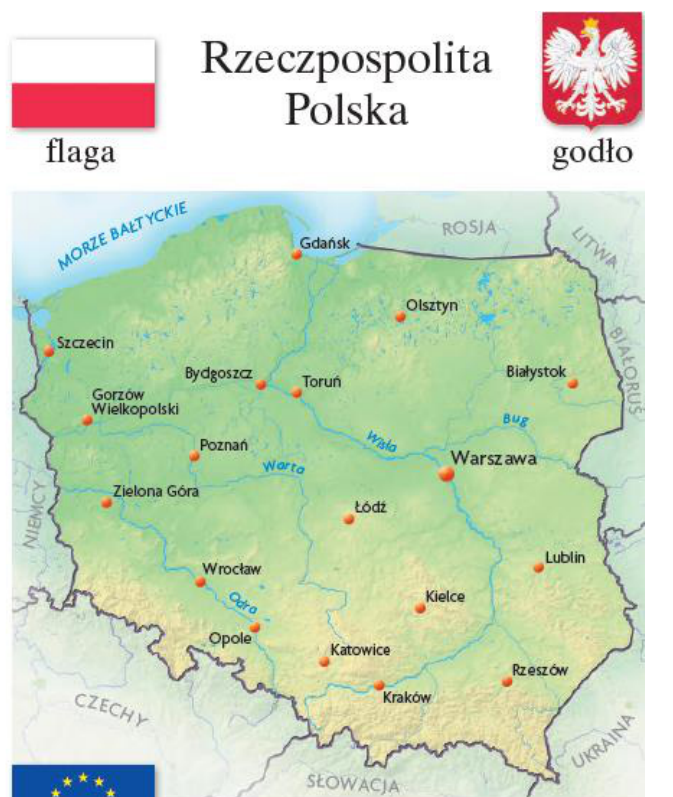
Fig. 1. The map of the Republic of Poland from Nasz elementarz (reduced, source: M. Lorek, L. Wollman,